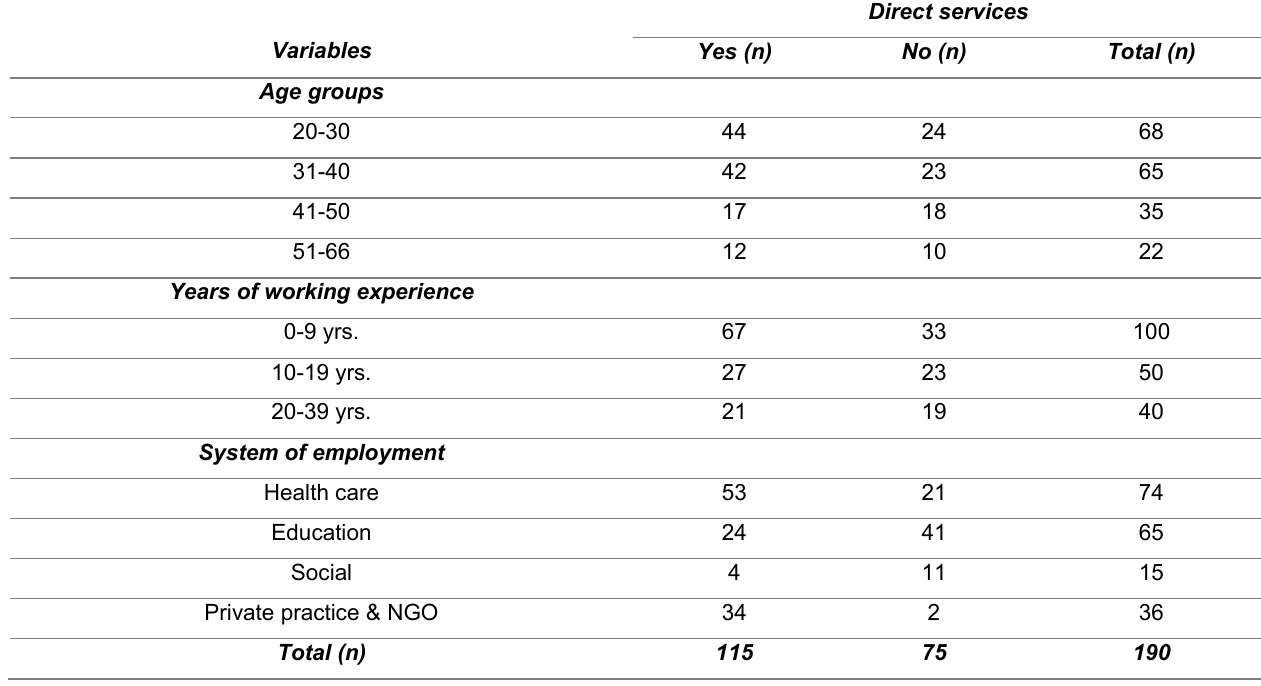
Frequency Distributions Indicating SLPs Who Implement and Do Not Implement Direct Therapy Services with Respect to Age, Years of Working Experience and System of Employment